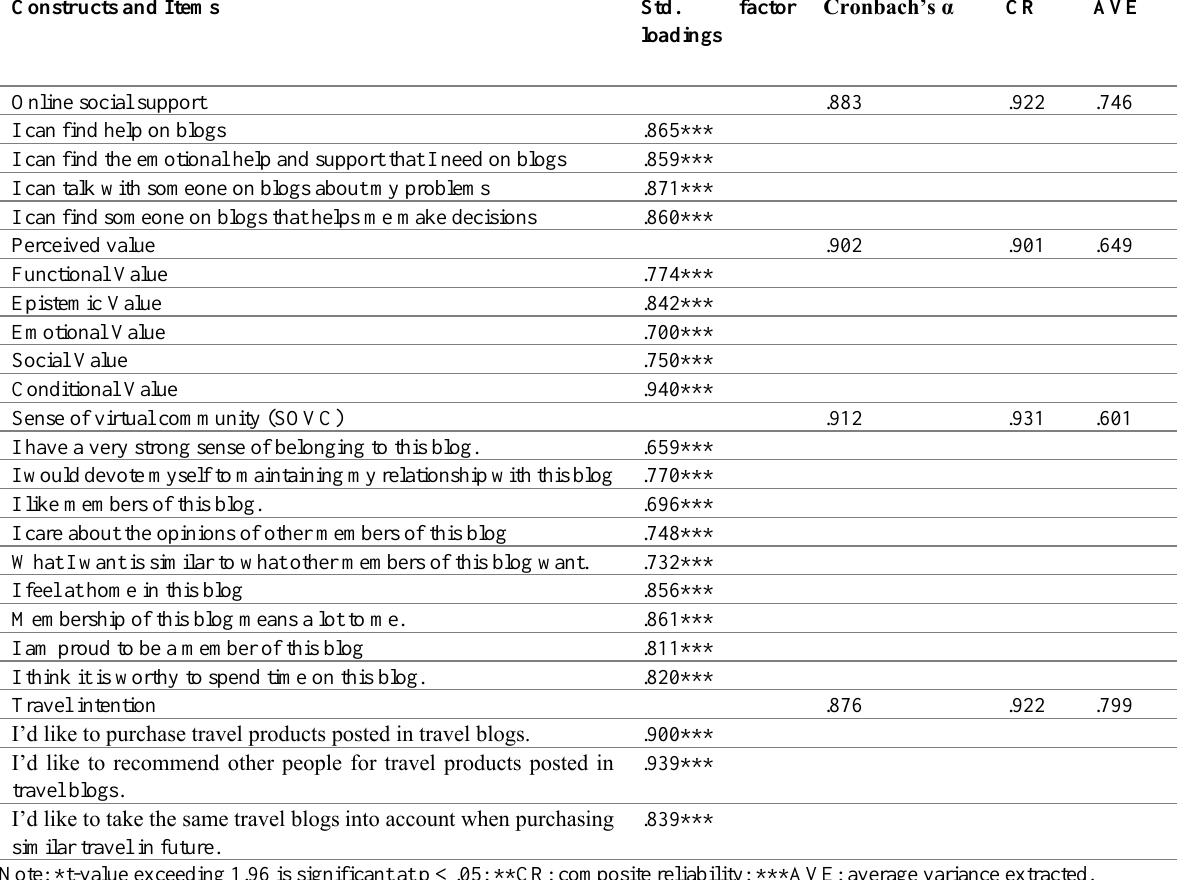
Table 2: Standardized Loadings and Reliabilities